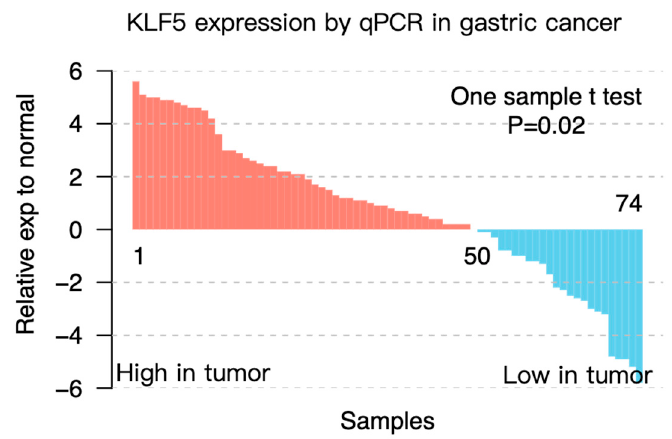
Figure 3. Expression of KLF5 in an independent cohort of gastric cancer samples. KLF5 expression was evaluated by real-time PCR in 74 pairs of gastric cancer and adjacent normal gastric tissues. Gastric cancer tissues showed higher KLF5 expression compared with adjacent normal control tissues (one-sample t -test: p = 0.02). Table 1. Clinicopathological characteristics of the patients grouped by KLF5 Expression.